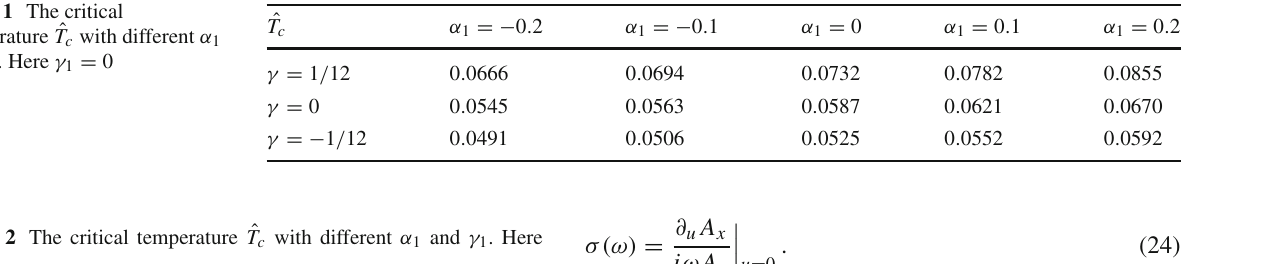
Table 2 The critical temperature ˆ T c with different α 1 and γ 1 . Here γ = 0